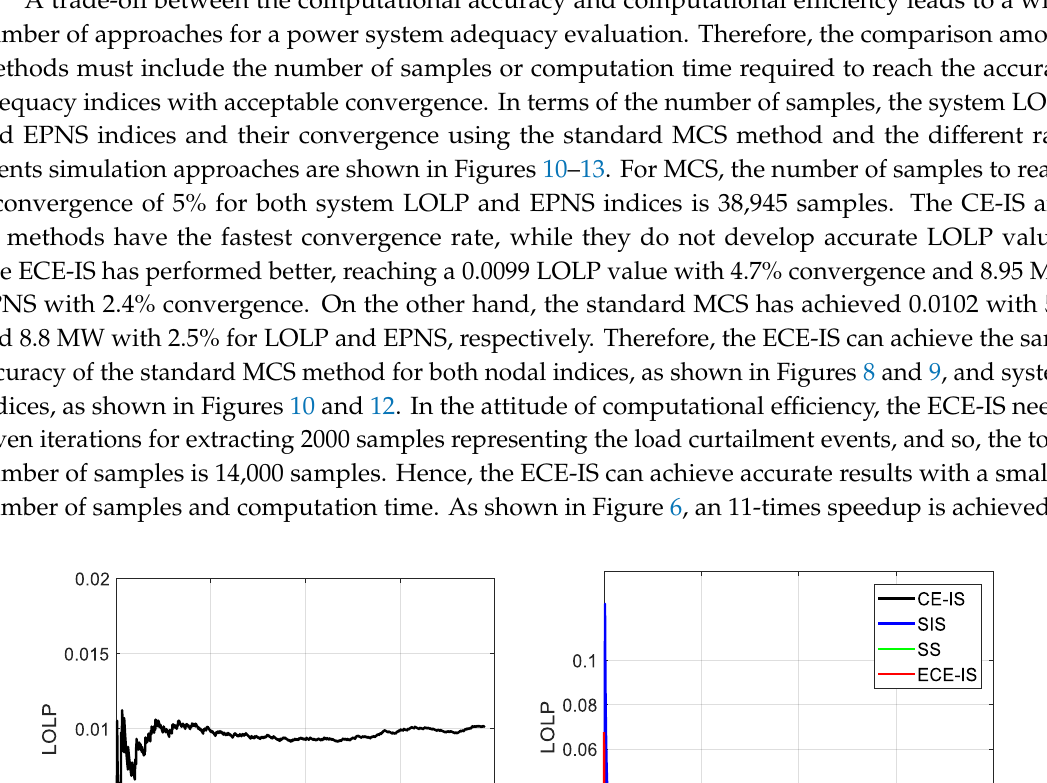
( a ) ( b ) Figure 11. ( a ) System LOLP convergence in case of using standard MCS method; ( b ) system LOLP convergence in case of using CE-IS, SIS, SS, and ECE-IS approaches. ( a ) ( b ) Figure 12. ( a ) System EPNS in case of using standard MCS method; ( b ) system EPNS in case of using CE-IS, SIS, SS, and ECE-IS approaches.